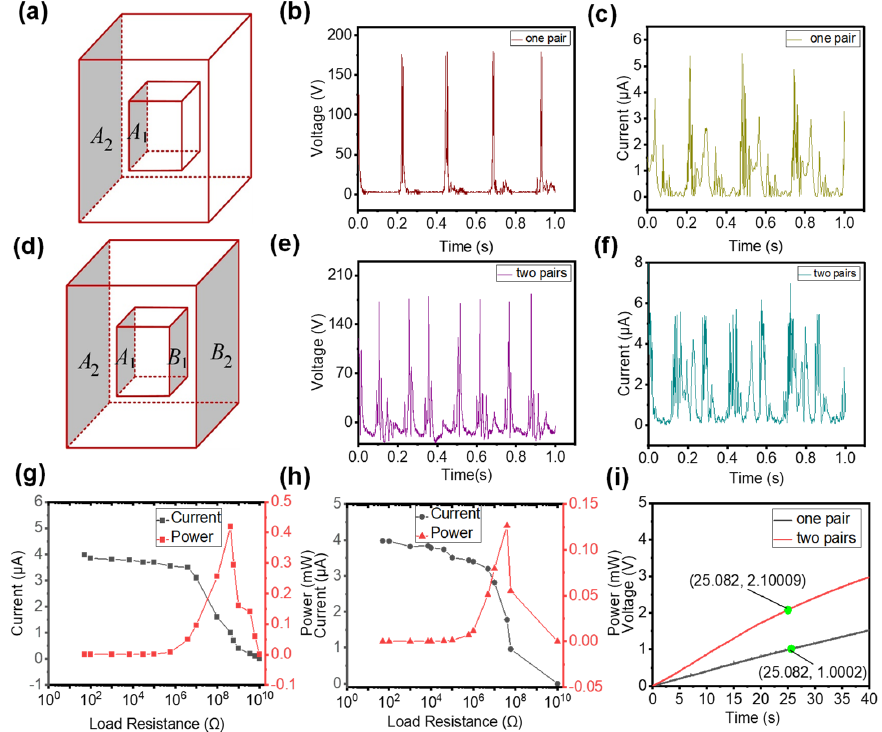
Figure 3. ( a ) Diagram of the CS-TENG with a single friction pair. ( b ) V OC of the CS-TENG with a single friction pair. ( c ) I SC of the CS-TENG with a single friction pair. ( d ) Diagram of the CS-TENG with two friction pairs. ( e ) V OC of the CS-TENG with two friction pairs. ( f ) I SC of the CS-TENG with two friction pairs. ( g ) Output peak power of the CS-TENG with a single friction pair. ( h ) Output peak power of the CS-TENG with two friction pairs. ( i ) Charging a 22 µ F capacitor using the two types of